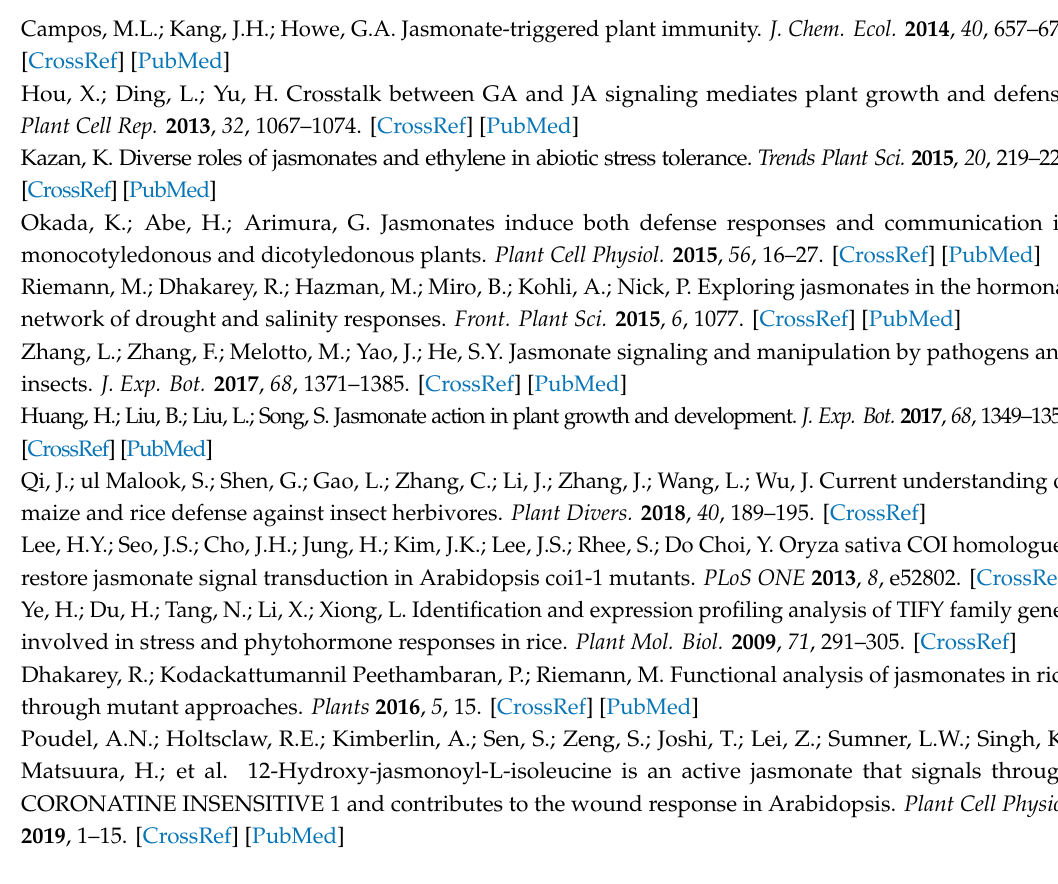
Table S1: Mutant and transgenic plants in jasmonates biosynthesis and signaling in rice. Author Contributions: All authors contributed to the writing and editing of this review